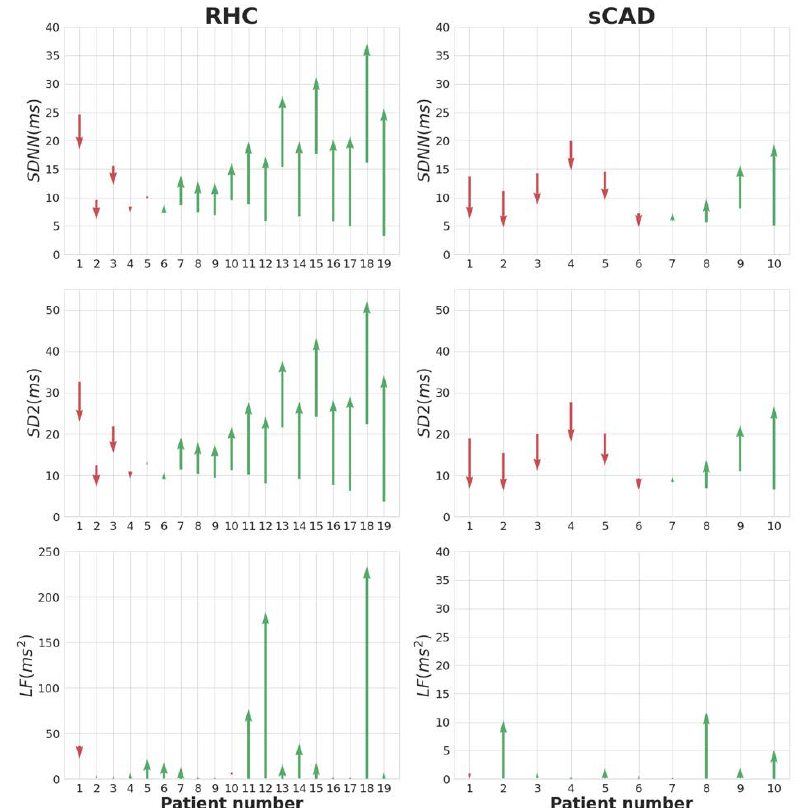
Figure 3. The HRV trend of each individual in the RHC and sCAD groups. The starting point of each arrow is the corresponding HRV value at the Max stage. The ending points of the arrows in